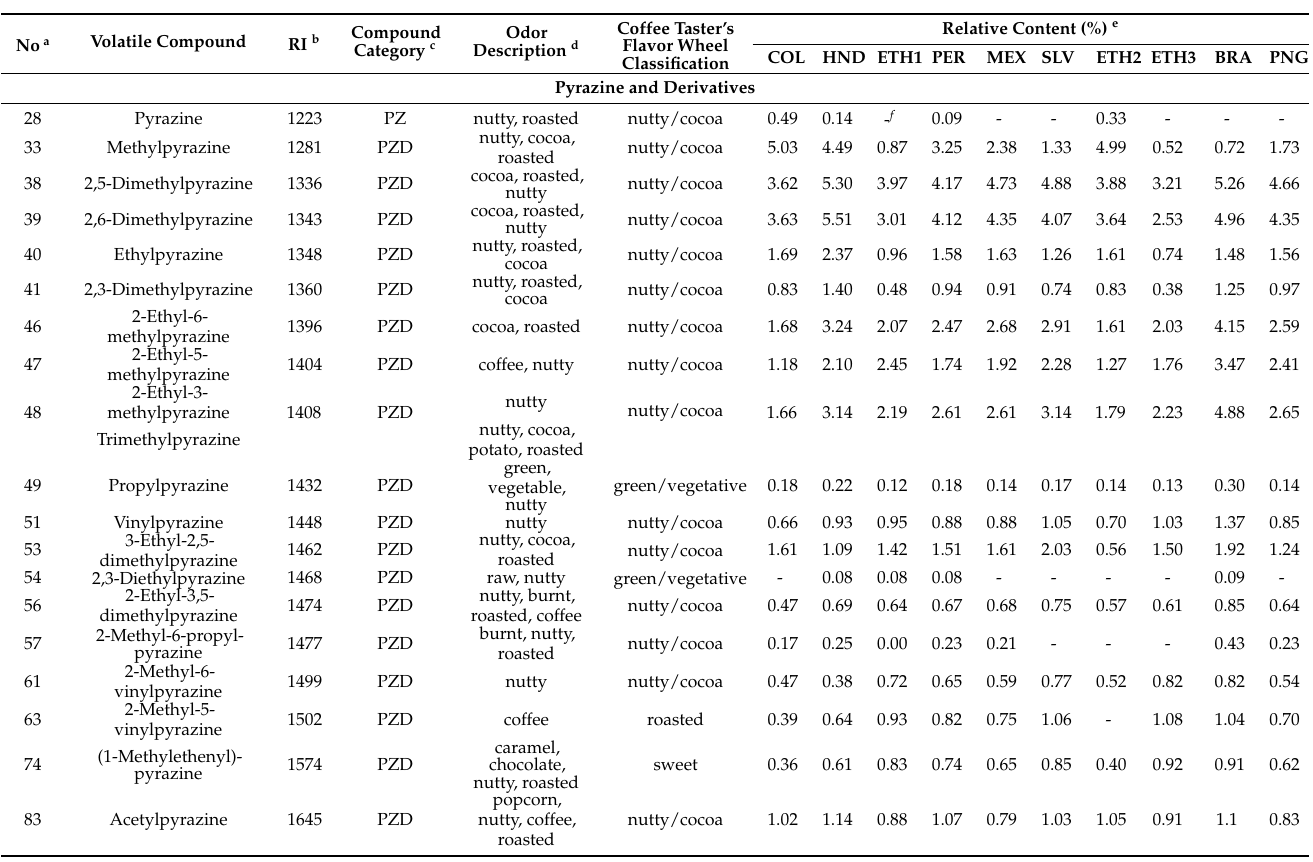
Figure 1. World map of single-origin coffee samples used in the study. Table 2. Volatile compounds identified in the studied coffee samples by headspace solid-phase microextraction with gas chromatography–mass spectrometry